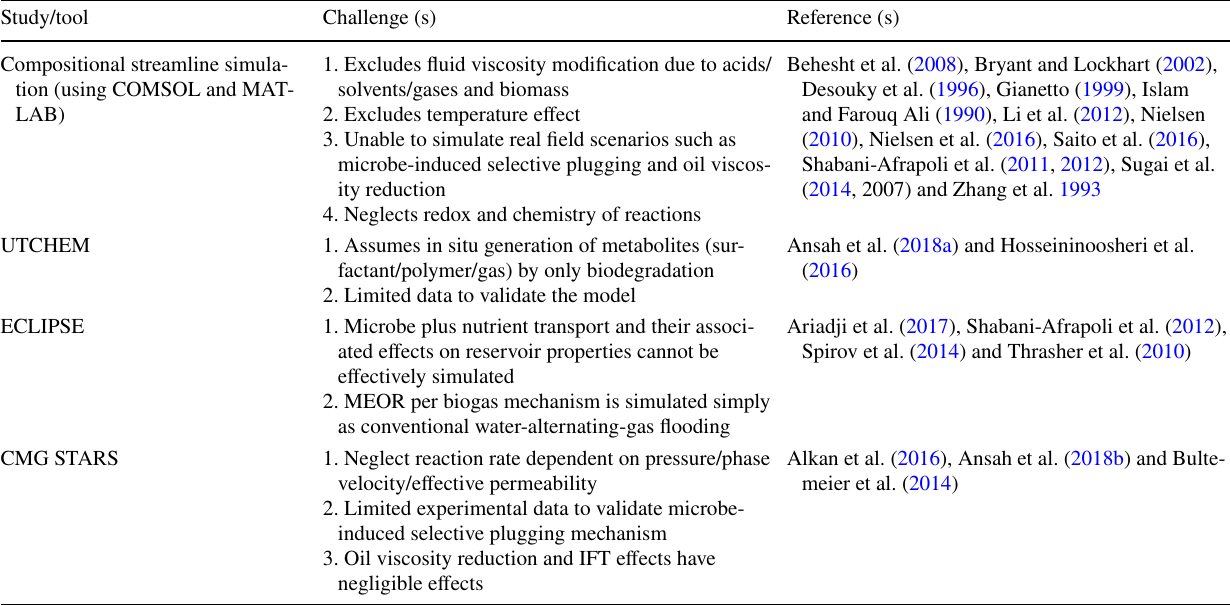
Table 1 Past studies related to microbial enhanced oil recovery (MEOR) modelling